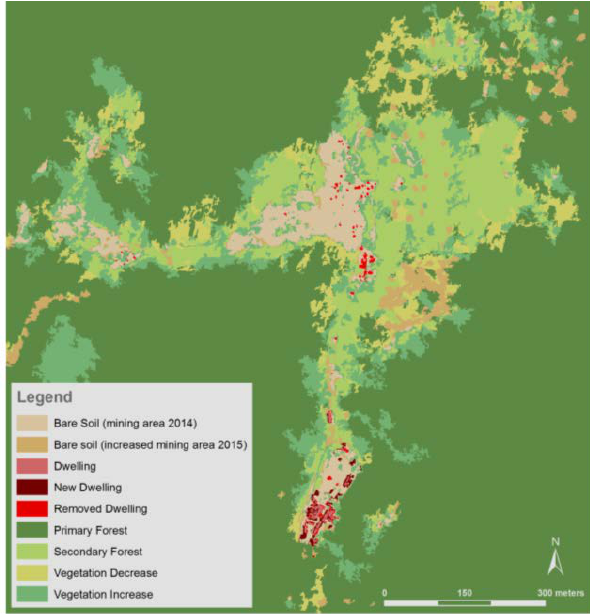
Fig. 6 . Results of the land cover change from June 2014 and March 2015.